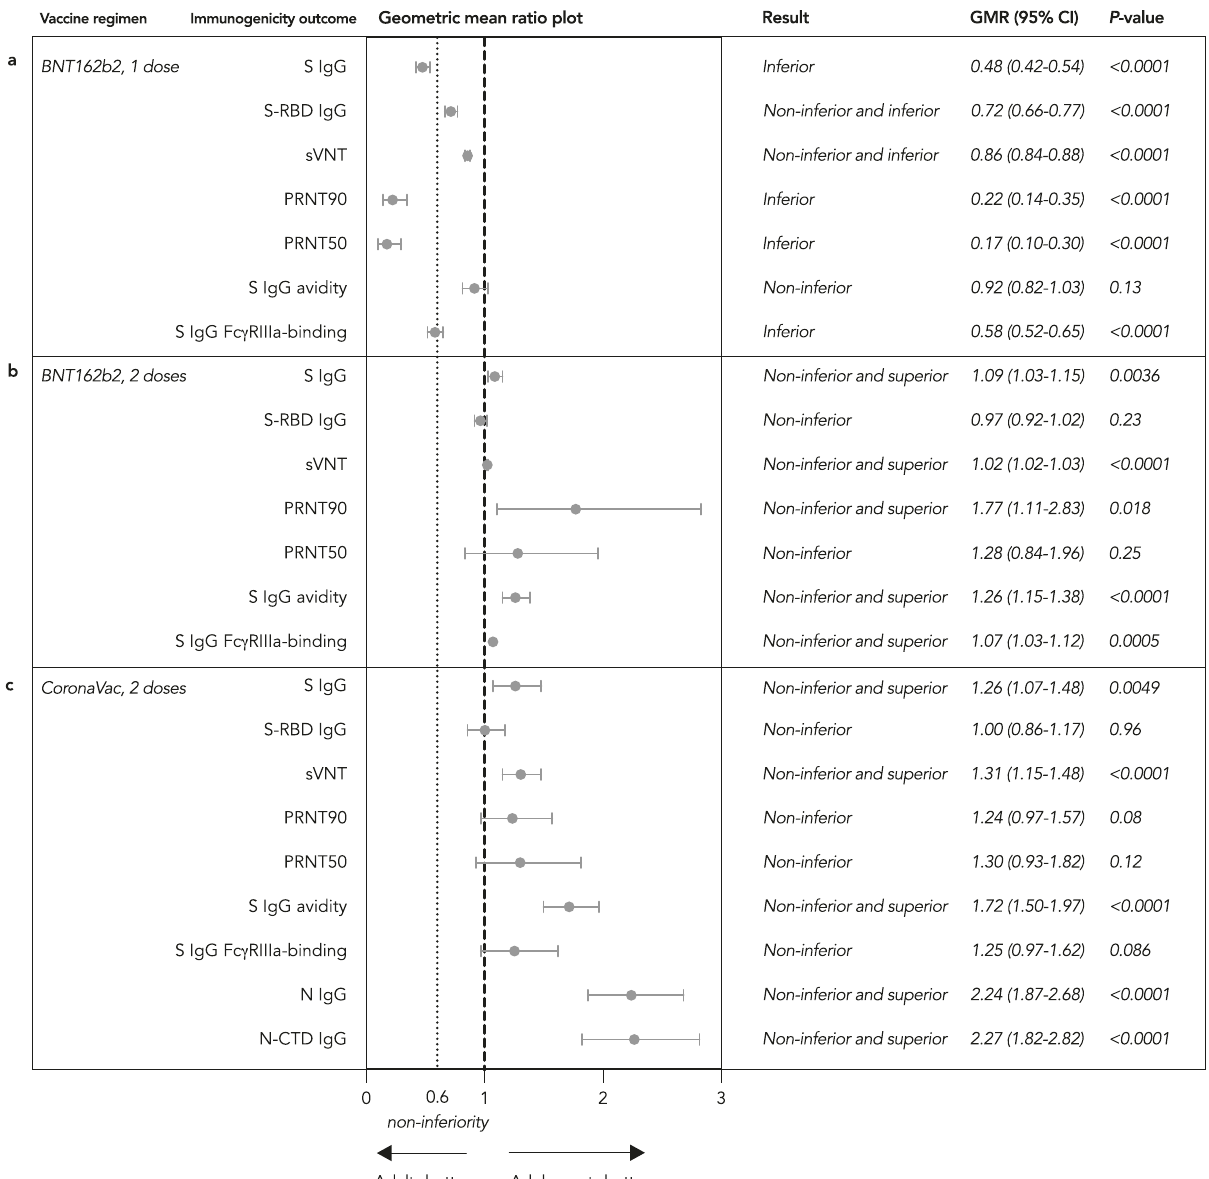
Fig. 1 Humoral immunogenicity outcomes for adolescents were mostly non-inferior in adolescents in comparison to adults. a One dose of BNT162b2 (B) in adolescents was non-inferior by S-RBD IgG (adolescent B N = 107, adult BB N = 115), sVNT (adolescent B N = 107, adult BB N = 115) and S IgG avidity (adolescent B N = 88, adult BB N = 114) but not by S IgG (adolescent B N = 101, adult BB N = 115), PRNT90 (adolescent B N = 63, adult BB N = 13), PRNT50 (adolescent B N = 63, adult BB N = 13) and S IgG Fc γ RIIIa-binding (adolescent B N = 101, adult BB N = 115) (all P < 0.0001, except S IgG avidity with P = 0.13), which failed the non-inferiority comparison to adults. Additionally, although non-inferiority was satis fi ed for S-RBD IgG and sVNT for B in adolescents, their CIs were also within the inferior ranges (both P < 0.0001). b In contrast, humoral responses in adolescents were non-inferior to adults after 2 doses of BNT162b2 (BB), as measured by S IgG (also superior, P = 0.0036, adolescent BB N = 103), S-RBD IgG ( P = 0.23, adolescent BB N = 103), sVNT (also superior, P < 0.0001, adolescent BB N = 104), PRNT90 (also superior, P = 0.018, adolescent BB N = 60), PRNT50 ( P = 0.25, adolescent BB N = 60), S IgG avidity (also superior, P < 0.0001, adolescent BB N = 103) and S IgG Fc γ RIIIa-binding (also superior, P = 0.0005, adolescent BB N = 103). c After 2 doses of CoronaVac (CC), adolescents also had non-inferior humoral responses to adults as assessed by S IgG (also superior, P = 0.0049, adolescent CC N = 116, adult CC N = 50), S-RBD IgG ( P = 0.96, adolescent CC N = 119, adult CC N = 51), sVNT (also superior, P < 0.0001, adolescent CC N = 119, adult CC N = 51), PRNT90 ( P = 0.08, adolescent CC N = 64, adult CC N = 19), PRNT50 ( P = 0.12, adolescent CC N = 64, adult CC N = 19), S IgG avidity (also superior, P < 0.0001, adolescent CC N = 109, adult CC N = 41) and S IgG Fc γ RIIIa-binding ( P = 0.086, adolescent CC N = 116, adult CC N = 50). Additionally for adolescent CC, N and N-CTD IgGs were non-inferior and superior for adolescents compared to adults (both P < 0.0001, adolescent CC N = 60, adult CC N = 36). GMR geometric mean ratio, CI con fi dence interval, S spike protein, RBD receptor-binding domain, N nucleocapsid protein, CTD C-terminal domain, sVNT surrogate virus neutralisation test, PRNT plaque reduction neutralisation test, Fc γ RIIIa Fc γ receptor IIIa.